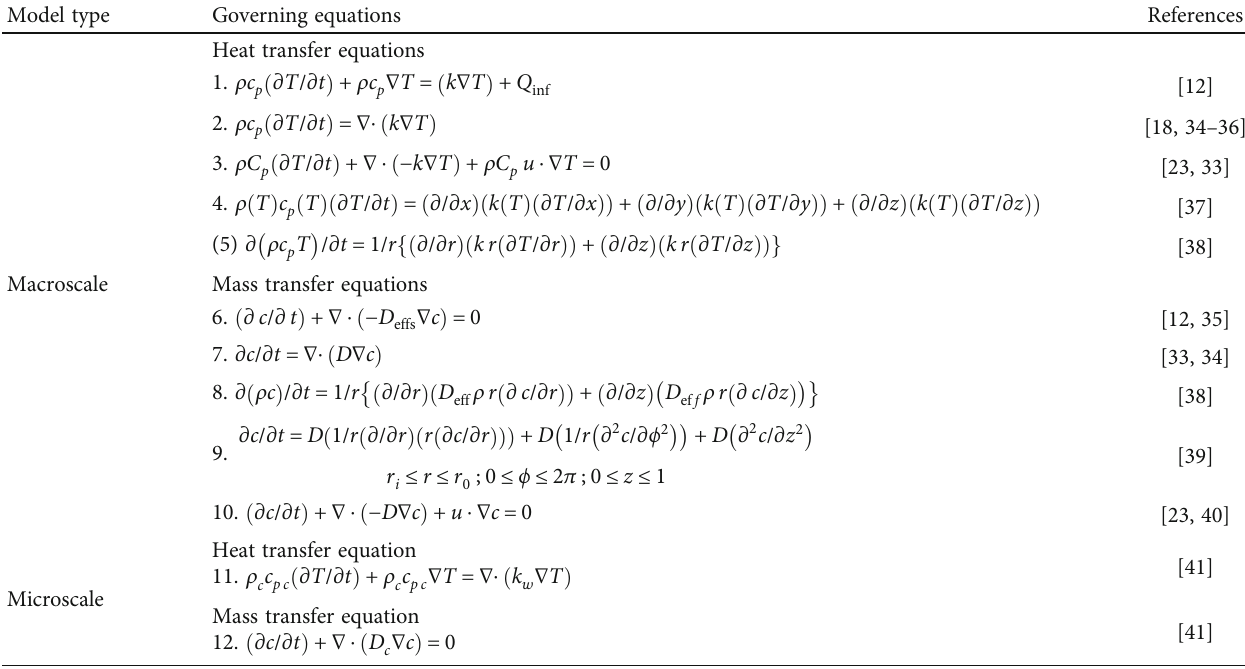
Figure 2: Classi fi cation of mathematical models in food drying [6, 26, 29 – 31]. Table 1: Transport equations during drying of fruits and